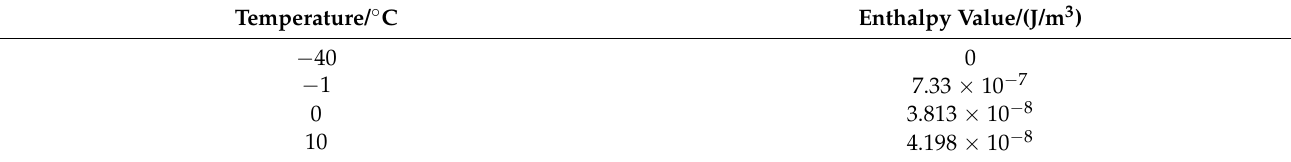
Table 9. Enthalpy values of ice at various temperatures.